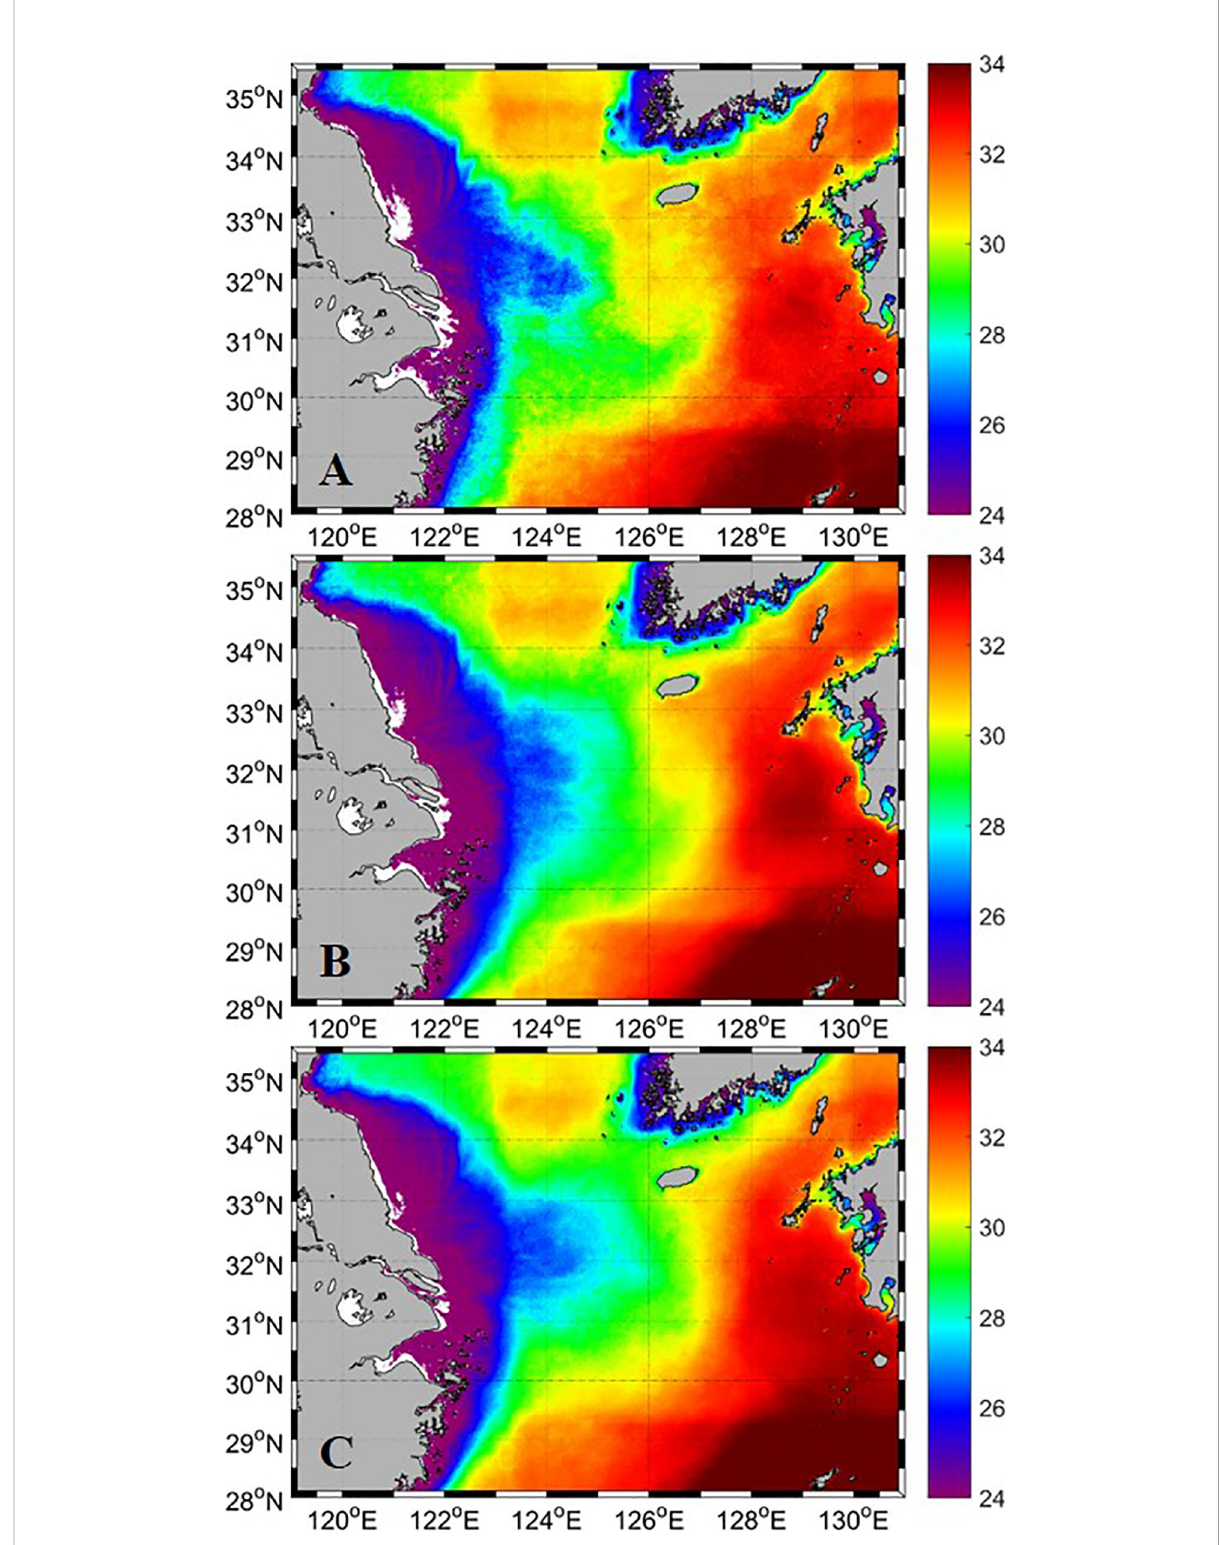
FIGURE 8 Satellite-derived salinities (psu) in (A) June, (B) July, and (C) August calculated using Eq.